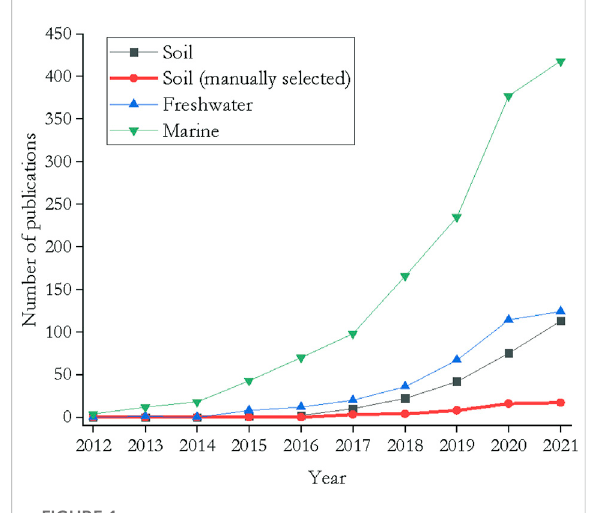
FIGURE 1 Number of studies published between 2012 and 2021 that examined the impact of micro- and nanoplastics in different environments. Search terms: for marine ecosystems (microplastic* OR nanoplastic*) AND (marine* OR sea*) AND (invertebrate* OR mesofauna* OR meiobenthos* OR organism*); for freshwater systems (microplastic* OR nanoplastic*) AND (freshwater* OR limn*) AND (invertebrate* OR mesofauna* OR meiobenthos* OR organism*); for soil (microplastic* OR nanoplastic*) AND (soil* OR terrestr*) AND (invertebrate* OR mesofauna* OR organism*). A manual selection of the hits was performed by excluding all publications that did not match the search terms (exclusion of false positives). Query performed on 12 October